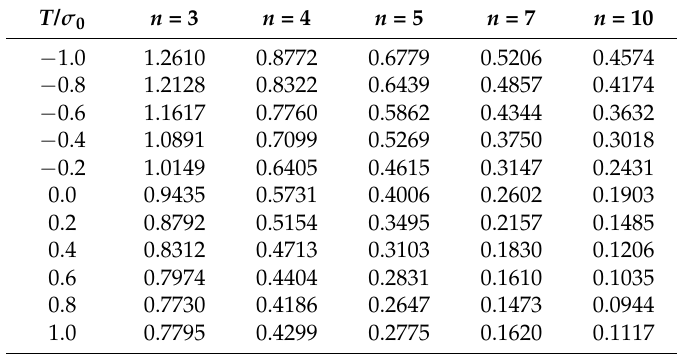
Figure 5. A-T relationship curves from 3D MBL formulation, for plane I ( a ) and II ( b ), λ =1.0. Table 1. Parameter A values from FEA results for 3D MBL formulation, in plane II, biaxial ratio λ =